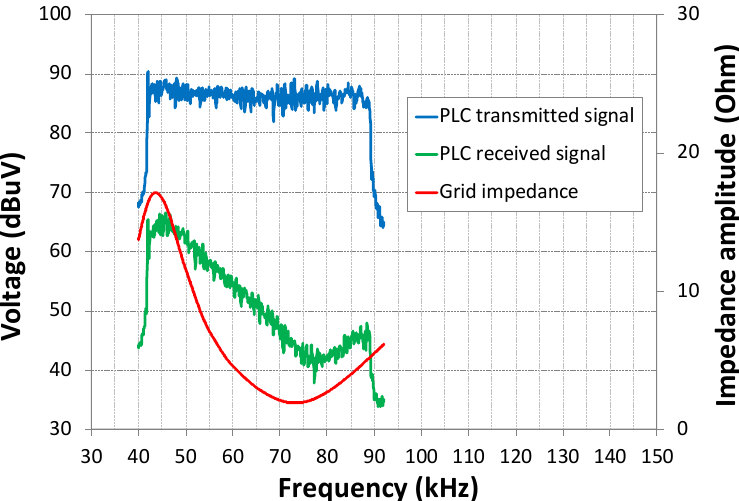
Figure 1. Impact of grid impedance on the communication between two smart meters located at the ends of a grid section: spectra of both Narrow Band Power Line Communications (NB-PLC) signals, registered in the transmitter and in the receiver, and frequency response of the grid impedance measured for that grid section.